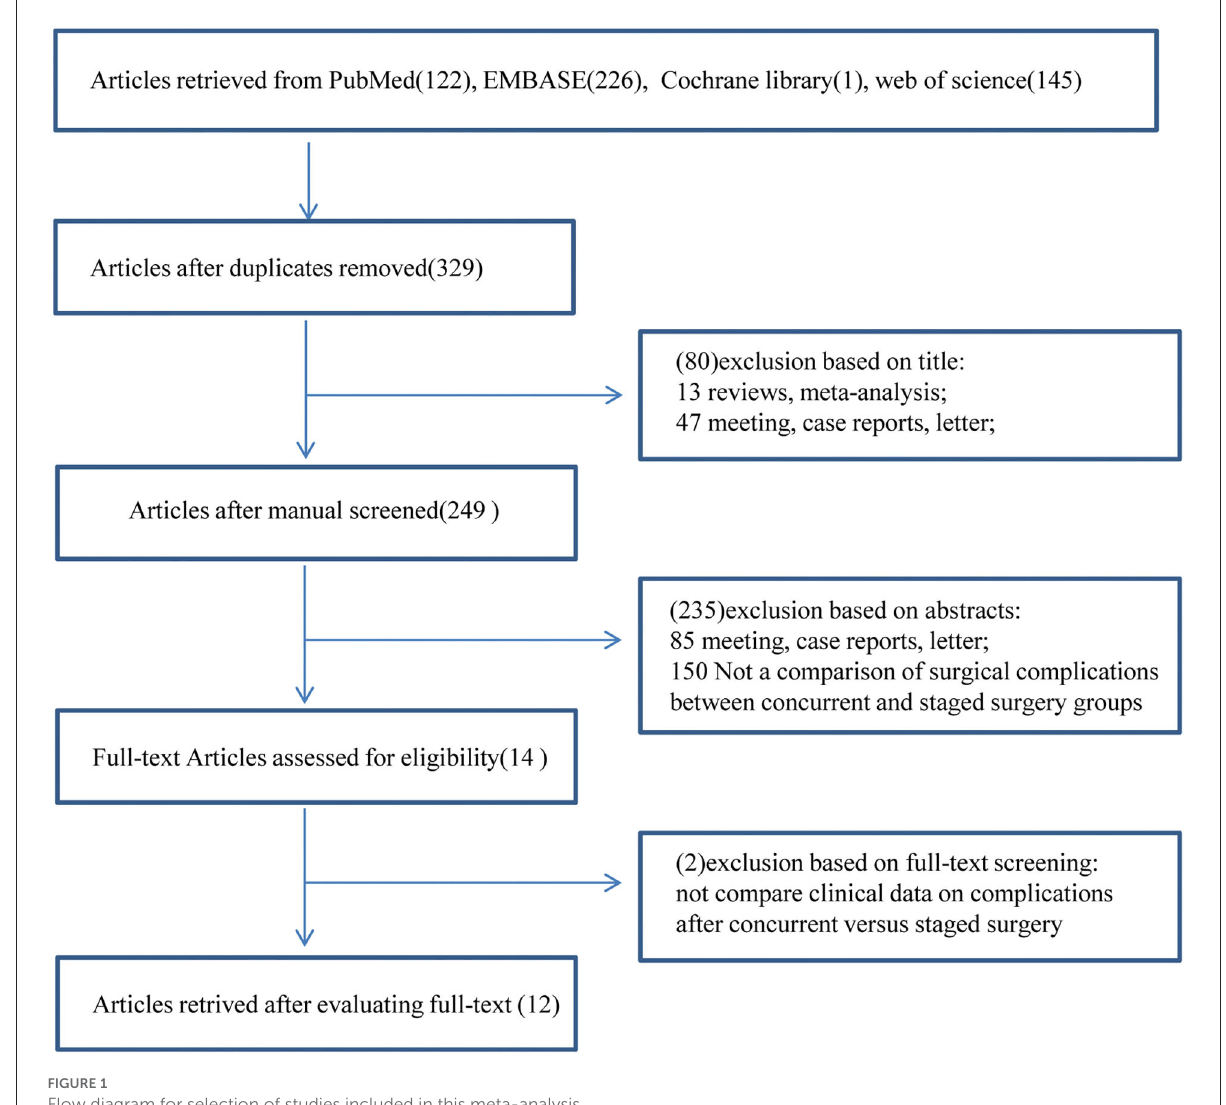
FIGURE1 Flow diagram for selection of studies included in this